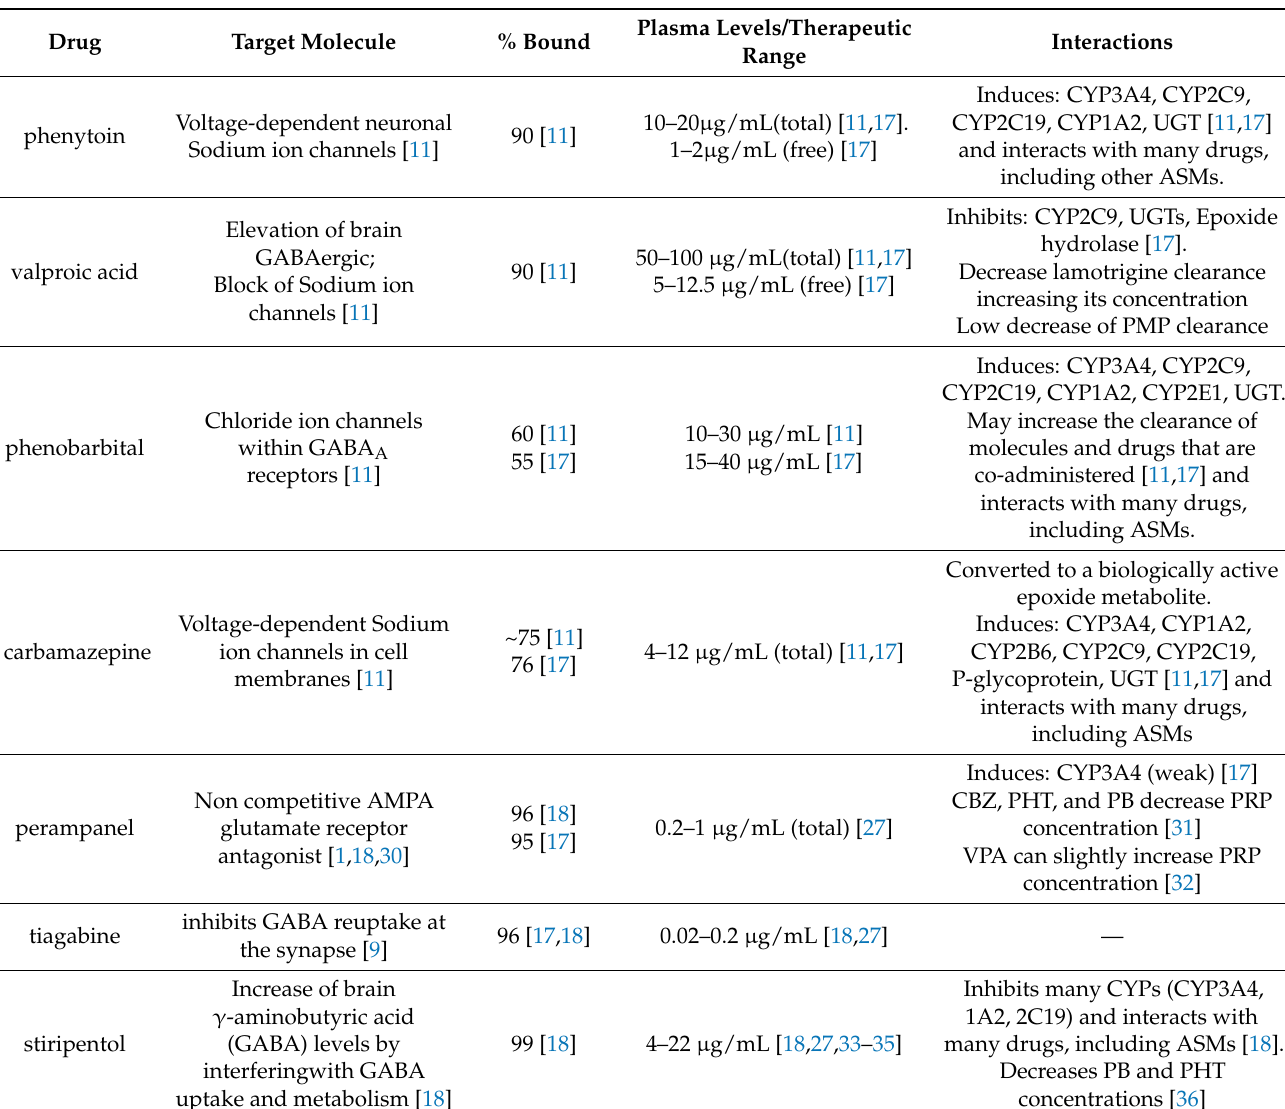
Table 1. Examples of highly bound